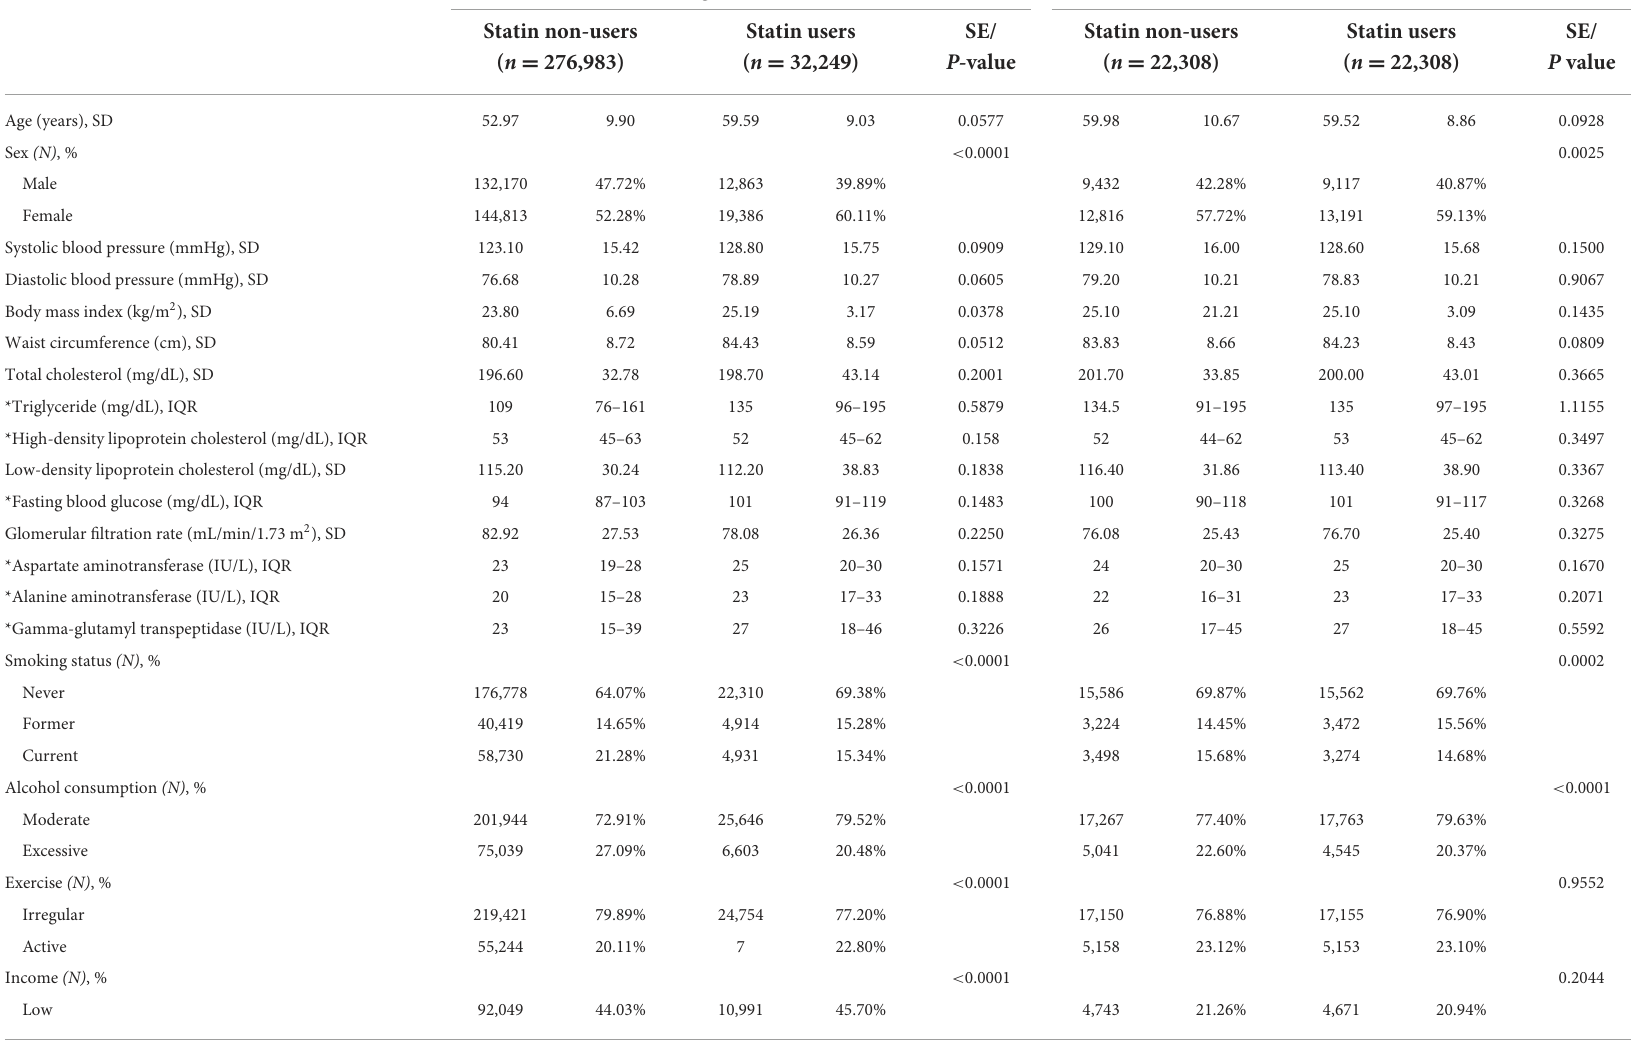
TABLE 1 Baseline characteristics of the study